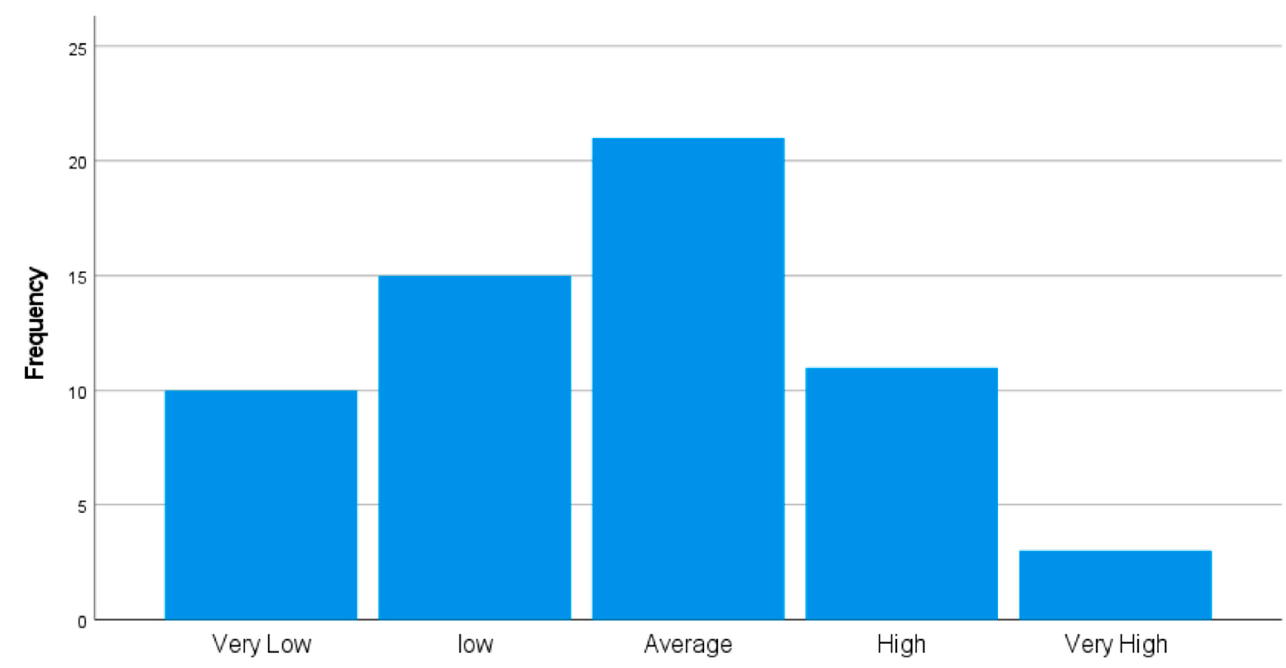
Figure 5. Total Culture Scaled. Table 5. Life expectancy.